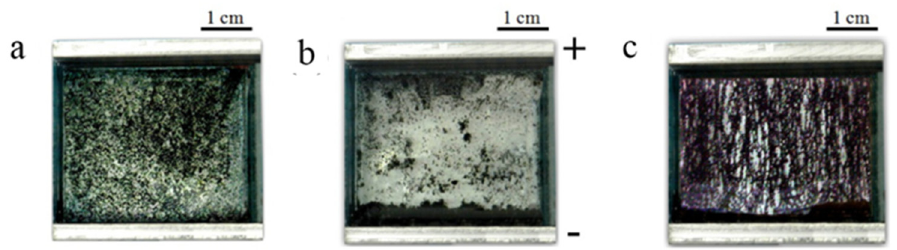
Figure 14. Optical photographs of MWCNT in distill water under an applied electric field. ( a ) V = 0 V, ( b ) V DC = 200 V after 120 s, ( c ) V AC = 400 V at 1 kHz after 5 s. Reproduced with permission [96].